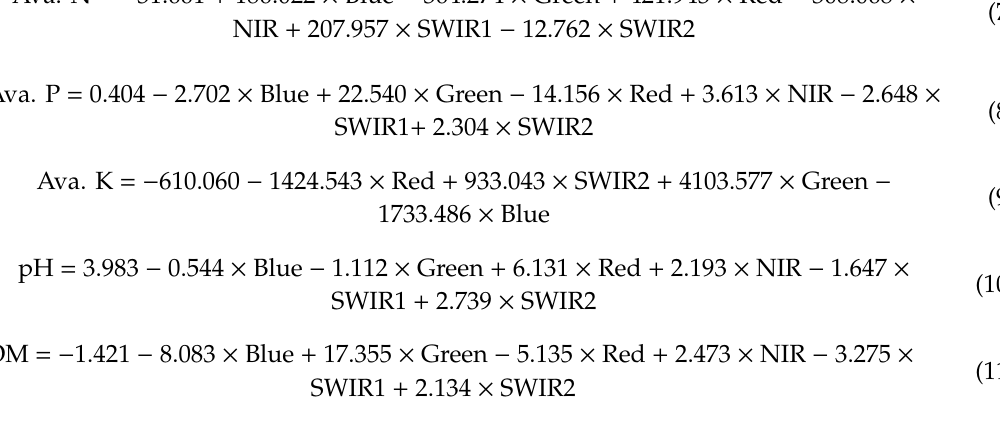
Table 7. Model validation of retrieved N, P, K, pH, and SOM from operational land imager (OLI) images. Properties